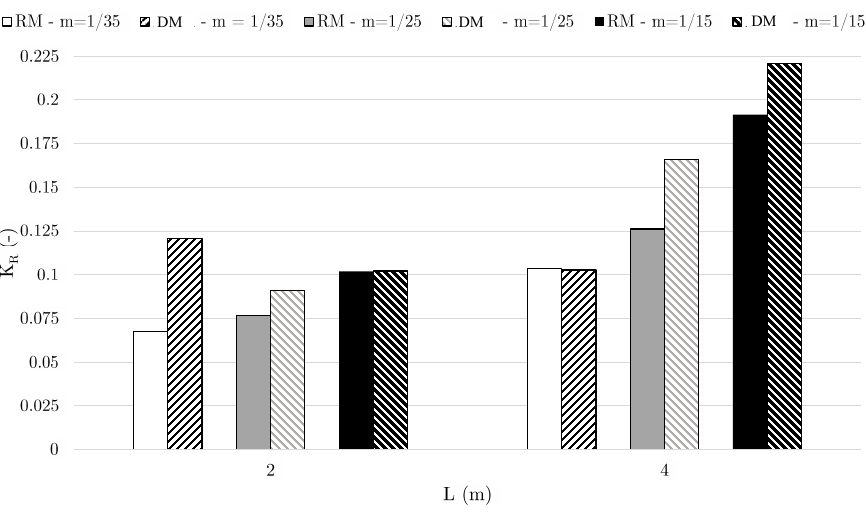
Figure 15. Reflection coefficients for different methods, waves and